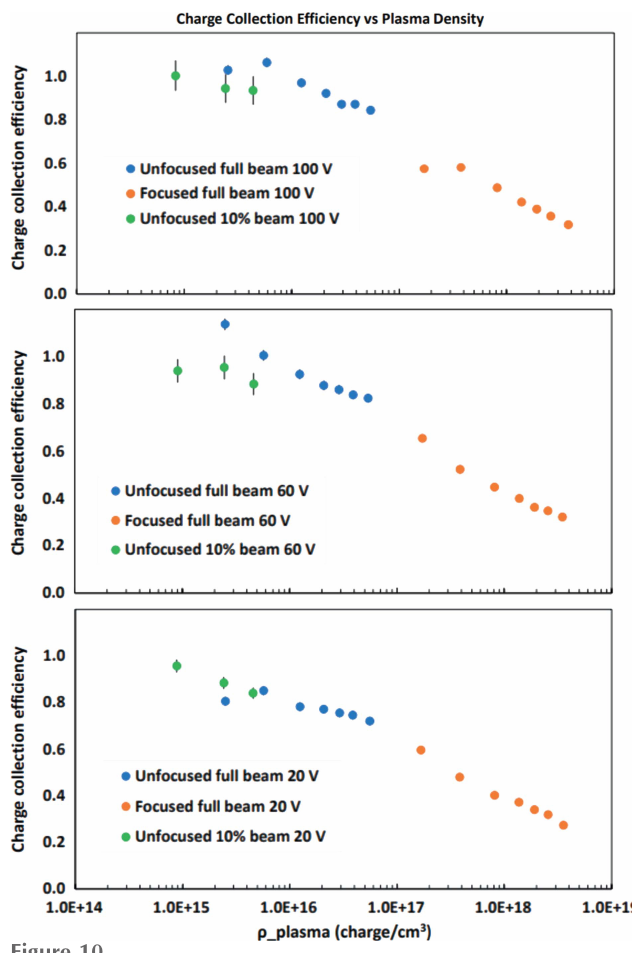
Figure 10 Estimated charge collection efficiency as a function of plasma density for 100 V, 60 V and 20 V sensor bias (bias fields of 2.7 V m m (cid:2) 1 , 1.6 V m m (cid:2) 1 and 0.54 V m m (cid:2) 1 , J. Synchrotron Rad. (2022). 29 , 595–601